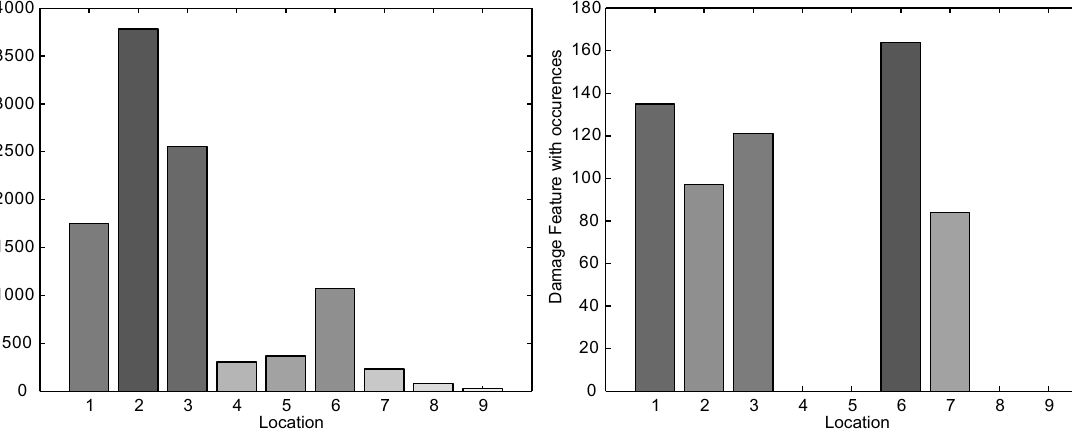
Fig. 13. Damage feature without and with occurrences for damaged structure and changing loading conditions, frequency range 60–120 Hz.